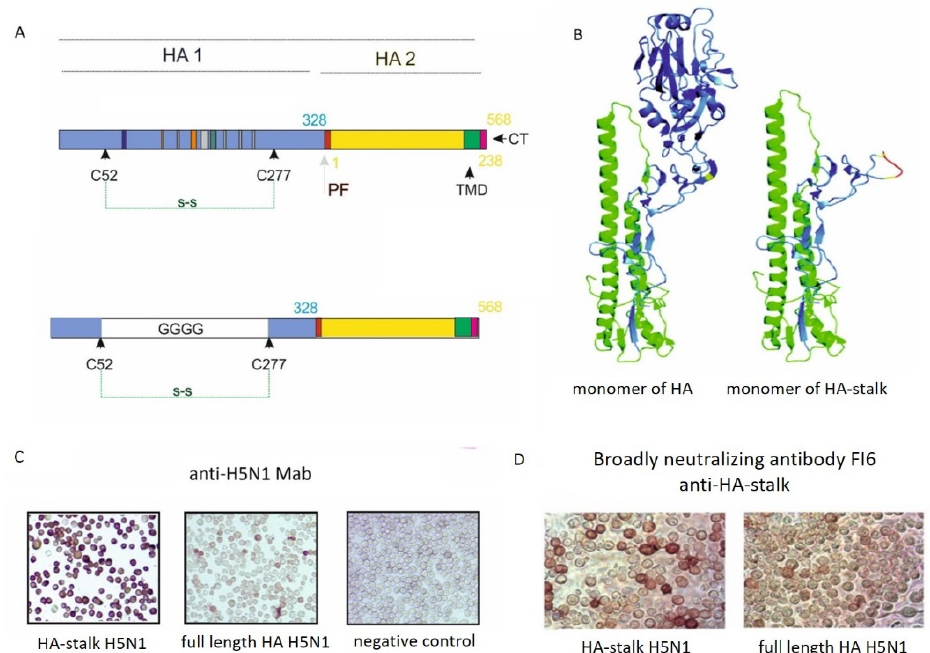
Figure 7. Construction and characterization of HA-stalk universal influenza antigen from homologous H5N1 HPAI virus strain. ( A ) Schematic representation of the full-length HA (top panel) and HA-stalk constructs (bottom panel). To obtain the HA-stalk construct, a glycine linker was added between cysteines in positions C52 and C277, replacing the head region of the HA1 domain. ( B ) Schematic representation of the predicted structure of HA monomer and HA-stalk monomer. ( C ) Expression of H5N1 HA-stalk in insect cells was confirmed by IPMA with anti-H5N1 monoclonal antibodies. Full-length HA from the H5N1 strain was used as a positive control. Cells infected with the wild type baculovirus were used as a negative control. Images were taken at × 10 magnification. ( D ) Reactivity of the HA-stalk antigen and full-length HA from H5N1 in the IPMA with broadly neutralizing universal FI6 human antibodies. HA-stalk and full-length HA from the H5N1 strain was detected in transfected insect cells. Images were taken at × 20